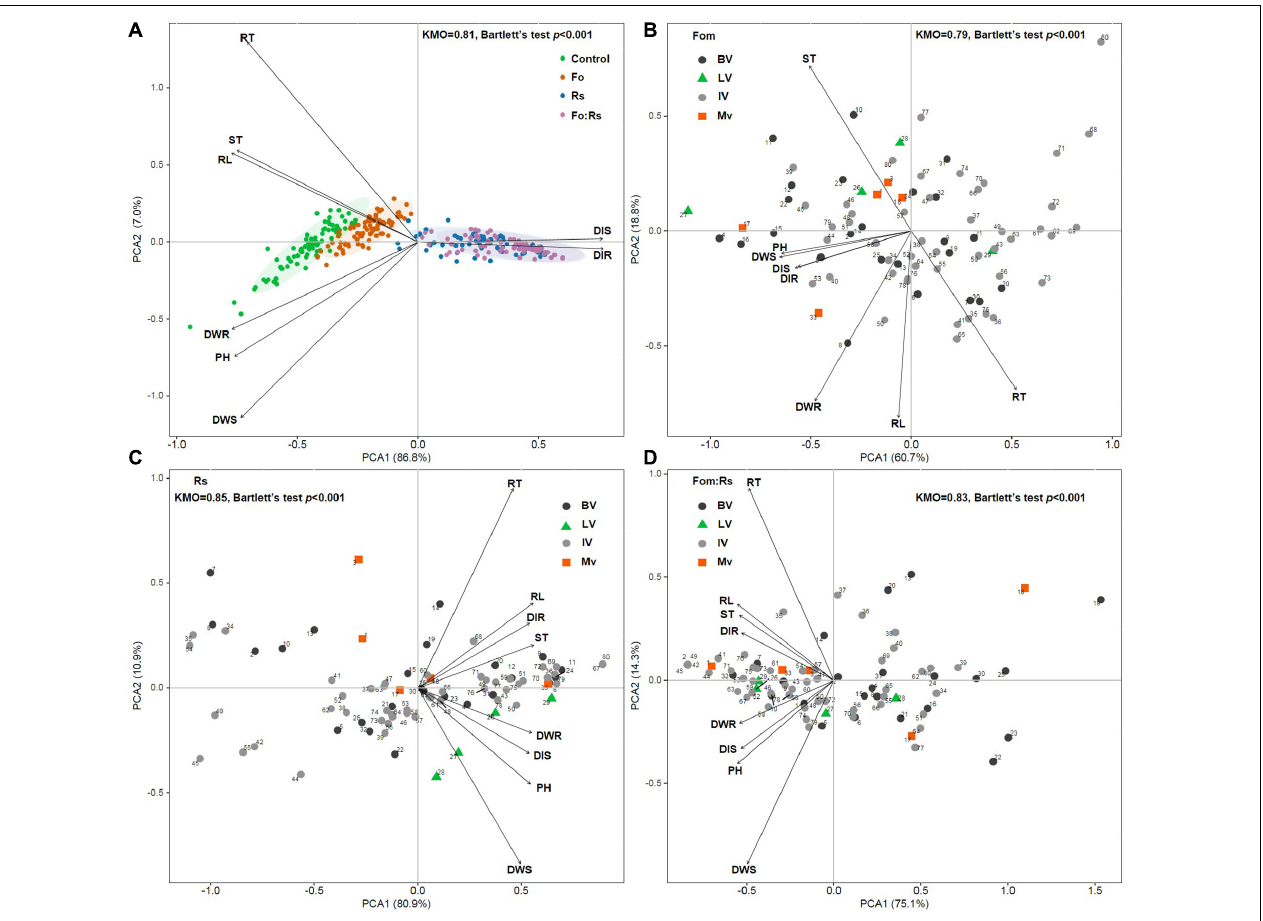
FIGURE 5 | Principal component analysis (PCA) on all plant traits and pathogen effect sizes for 80 alfalfa varieties single or co-inoculated with Fom and Rs. (A) PCA of all plant traits under the control and three pathogen treatments. PCA on pathogen effect sizes of plant traits under (B) single inoculation with Fom (Fom), (C) single inoculation with Rs (Rs), and (D) co-inoculation with Fom and Rs (Fom:Rs). Biplot vectors are trait factor loadings, whereas the position of each variety is shown. Kaiser–Meyer–Olkin (KMO) measure of sampling adequacy and Bartlett’s test of sphericity are shown. The study includes 75 M. sativa subsp. sativa (Ms) varieties consisting of 24 domestic bred (BV, circles in black), 4 local varieties (LV, triangles) in China, and 47 introduced varieties overseas (IV, circles in gray), and 5 M. sativa subsp. varia domestic bred varieties (Mv, squares). Numbers of varieties shown in panels (B–D) corresponds to those shown in Supplementary Table 1